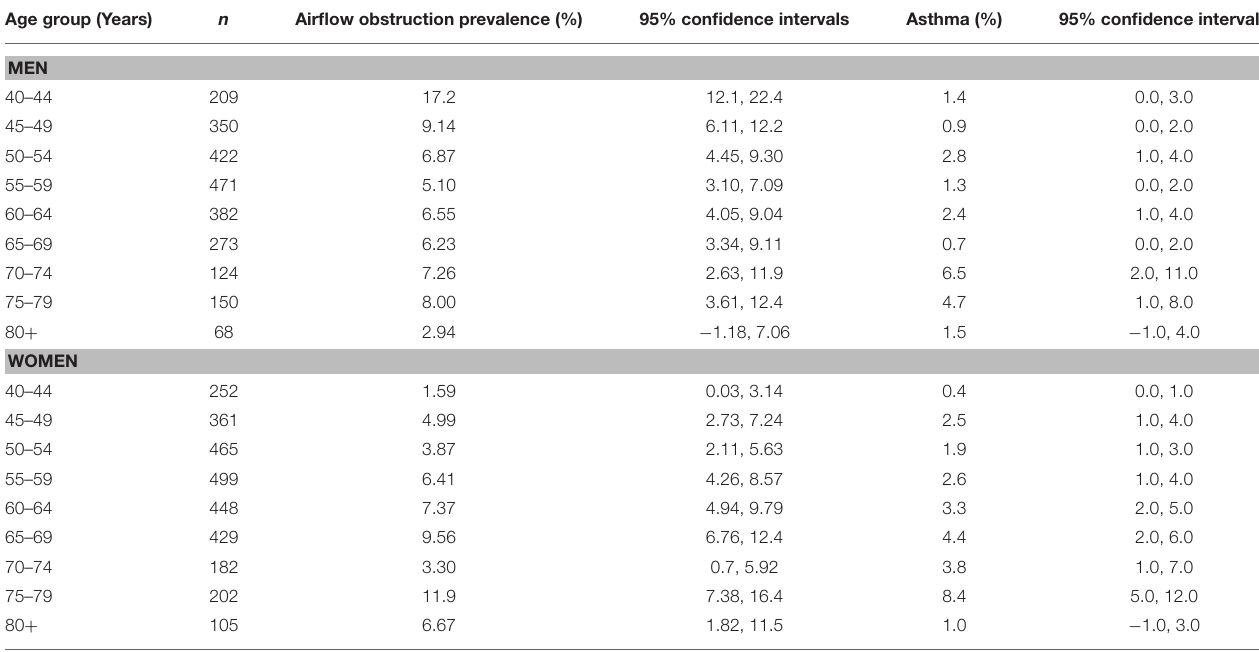
TABLE 3 | Prevalence of airflow obstruction disease and asthma in the Ural Eye and Medical Study, stratified by sex and age. Age group (Years)